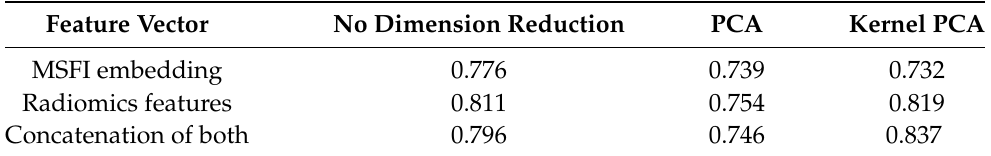
Table 3. Comparison of pCR prediction performance of various combinations of feature vectors and dimension reduction methods. Three types of feature vectors, { radiomics features, MSFI embedding, concatenation of both } , and three dimension reduction methods, { No dimension reduction, PCA, and Kernel PCA } , are considered. The pCR classification model is fixed to a random